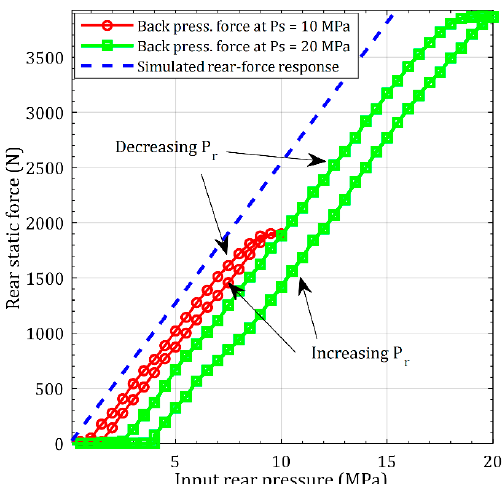
Figure 12. Comparison of model predicted forces along with measured force characteristics changing with a change in the pressure in the rear chamber for two different supply pressure settings.